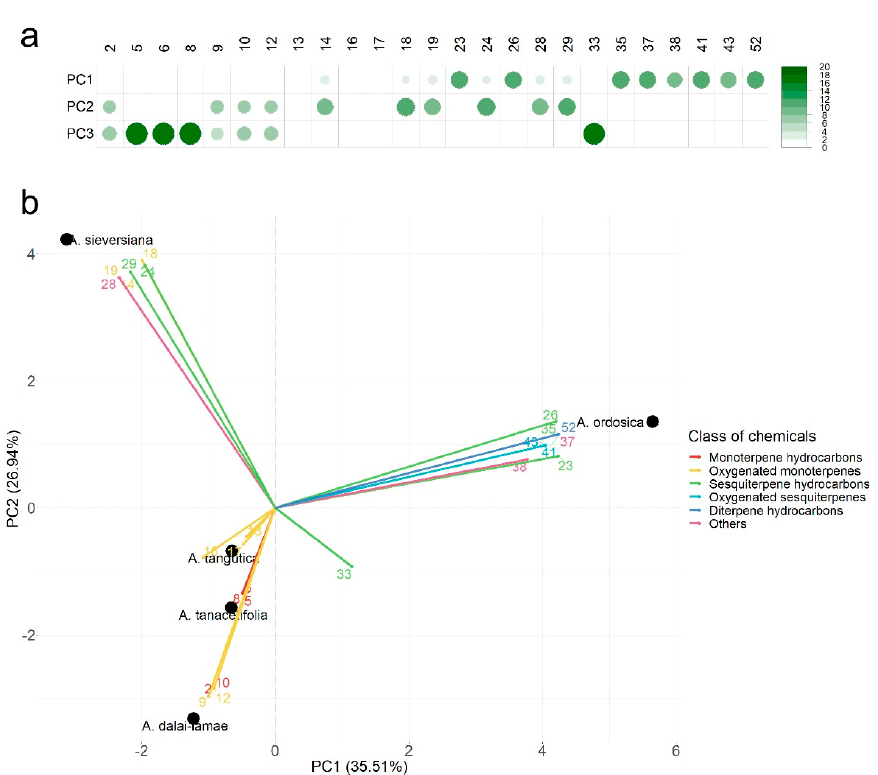
Figure 1. Principal component analysis (PCA) of five Artemisia species according to the major essential oil compositions (concentration > 3%). ( a ) the contribution (%) of chemical constituents to the first two principal components; ( b ) bi-plot of PCA. The serial numbers of components are consistent with those in Table 1.